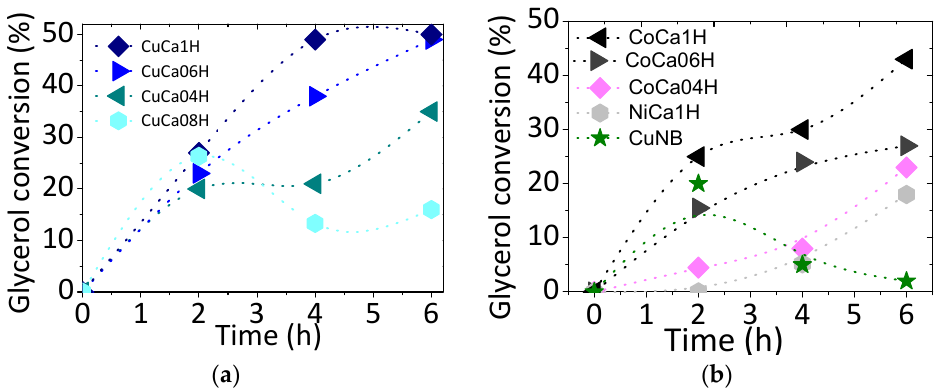
Figure 2. Time-dependence evolution of glycerol conversion for the solids studied: ( a ) Cu-containing hydroxyapatites and ( b ) co-containing hydroxyapatites, NiCa1H and CuNB catalysts. Reaction conditions: 75 mg of catalyst, glycerol to acetic acid molar ratio of 0.25, and reaction temperature = 80 °C.